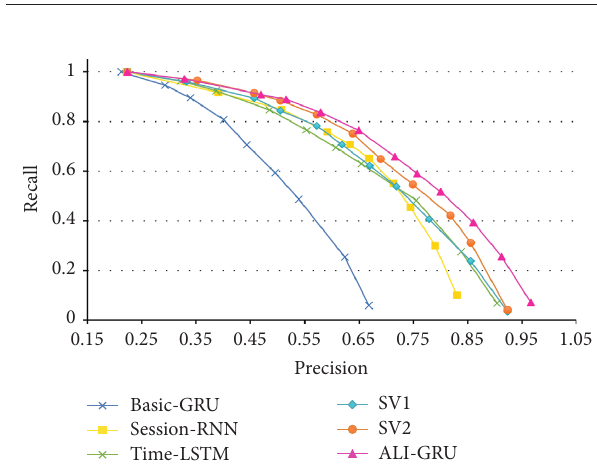
Figure 5: Precision-Recall curves of different methods on offline